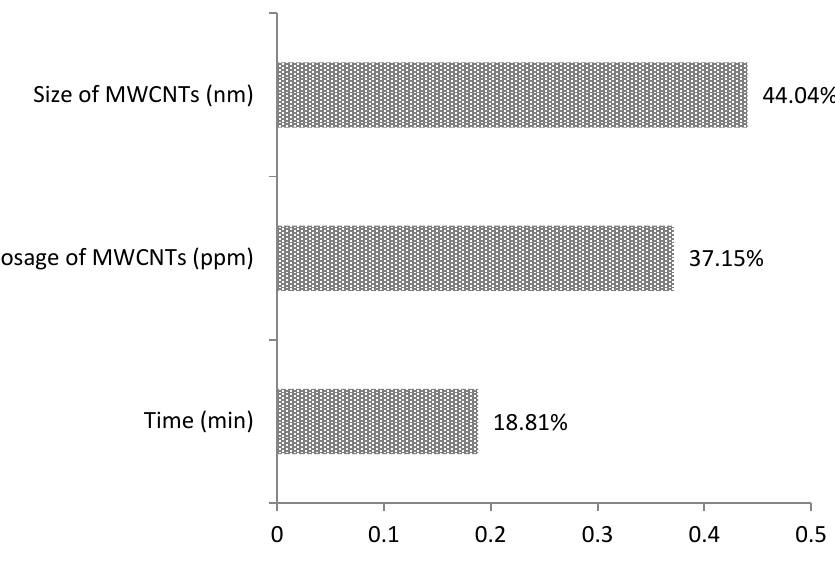
Figure 9. Sensitivity analysis of parameter.